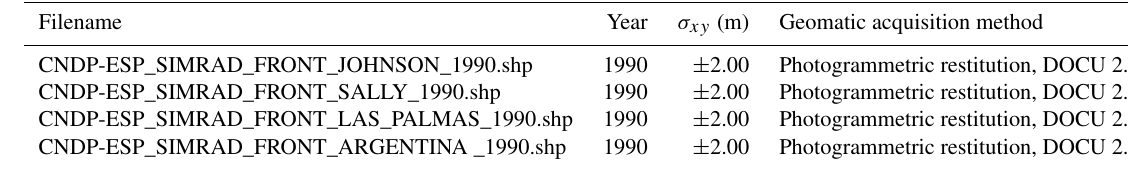
Table 3. ARCGIS shape files for the UKHO photogrammetric flight of 1990. In the third column the RMS error is shown.